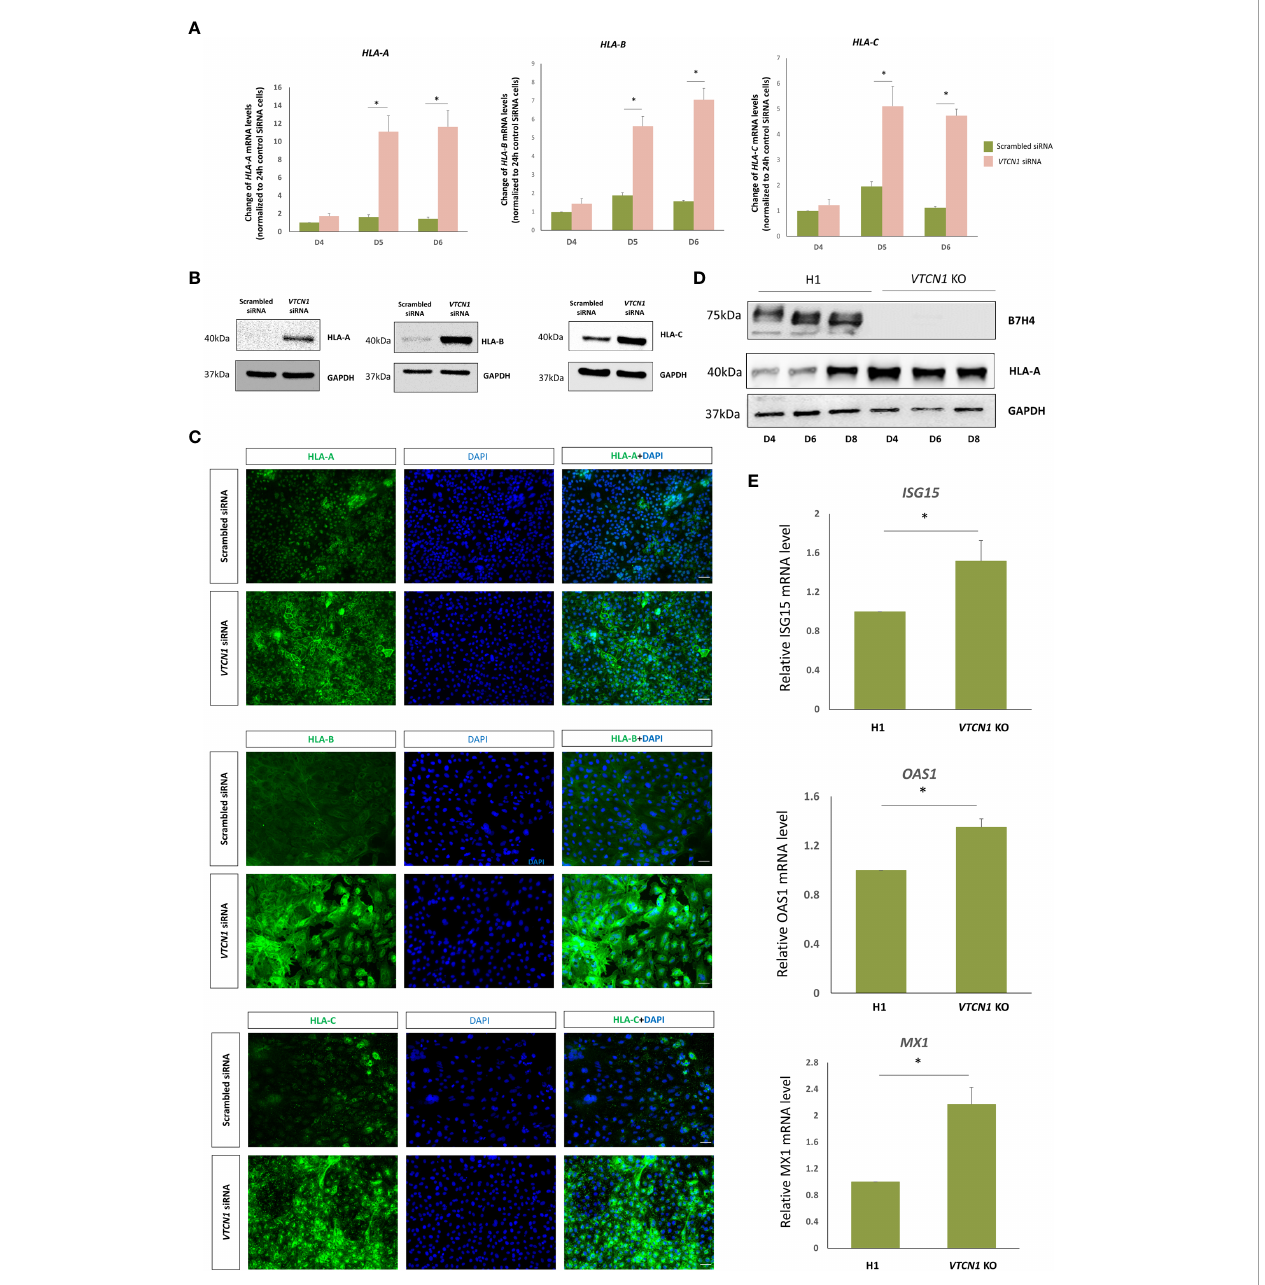
FIGURE 5 BAP treated H1 ESC were transiently transfected with VTCN1 siRNA or a scrambled siRNA control for 3d. (A) The effects of VTCN1 KD on HLA-A, HLA-B and HLA-C transcription were assessed by RT-PCR. Data represents means ± SD of three independent experiments; statistically signi fi cant comparisons to scrambled control siRNA are indicated by asterisks (p<0.05). (B) Protein was collected on BAP d6 (transfection d3) and the expression of HLA-A, HLA- B and HLA-C were assessed by western blotting (C) Immuno fl uorescence microscopy was performed to assess the expression of HLA-A, HLA-B